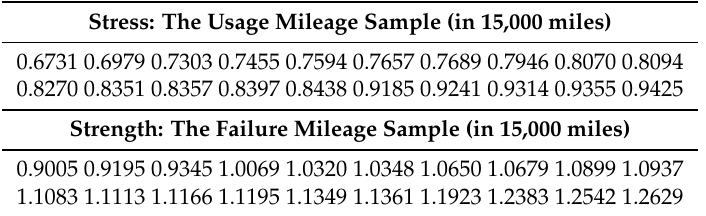
Table 8. The stress of usage mileage and the strength of failure mileage random